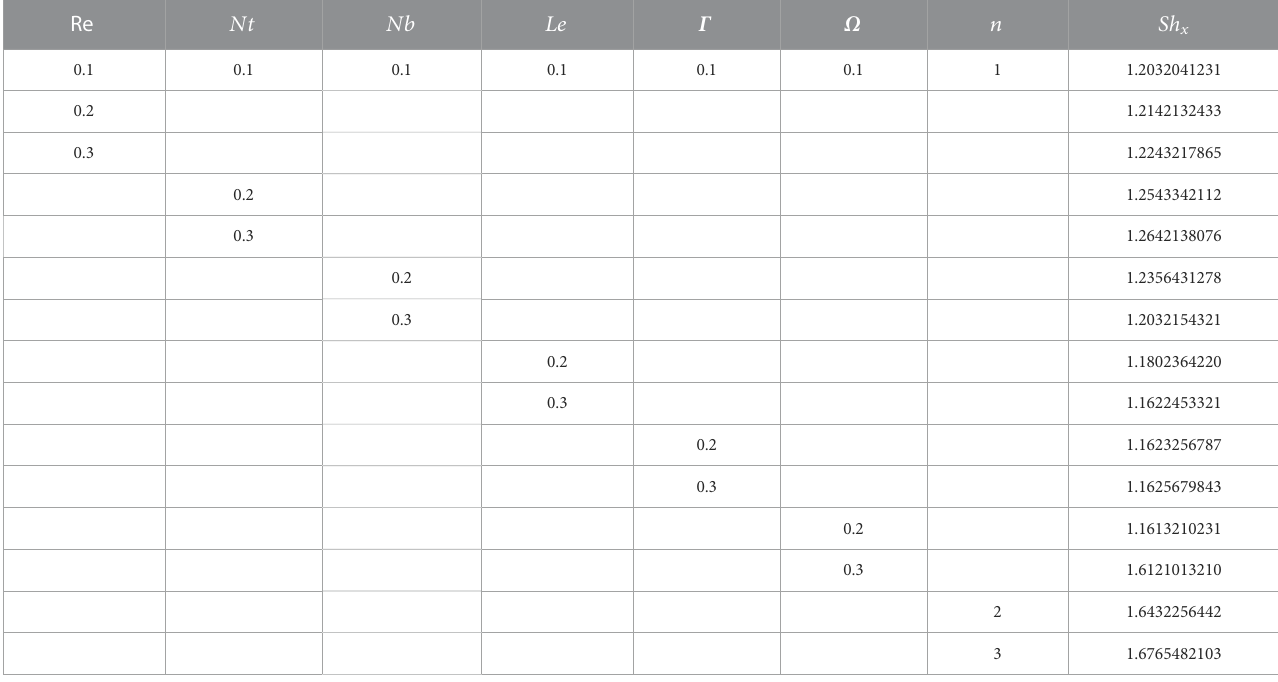
TABLE 4 Sherwood number against different factors for the Maxwell nano fl uid.